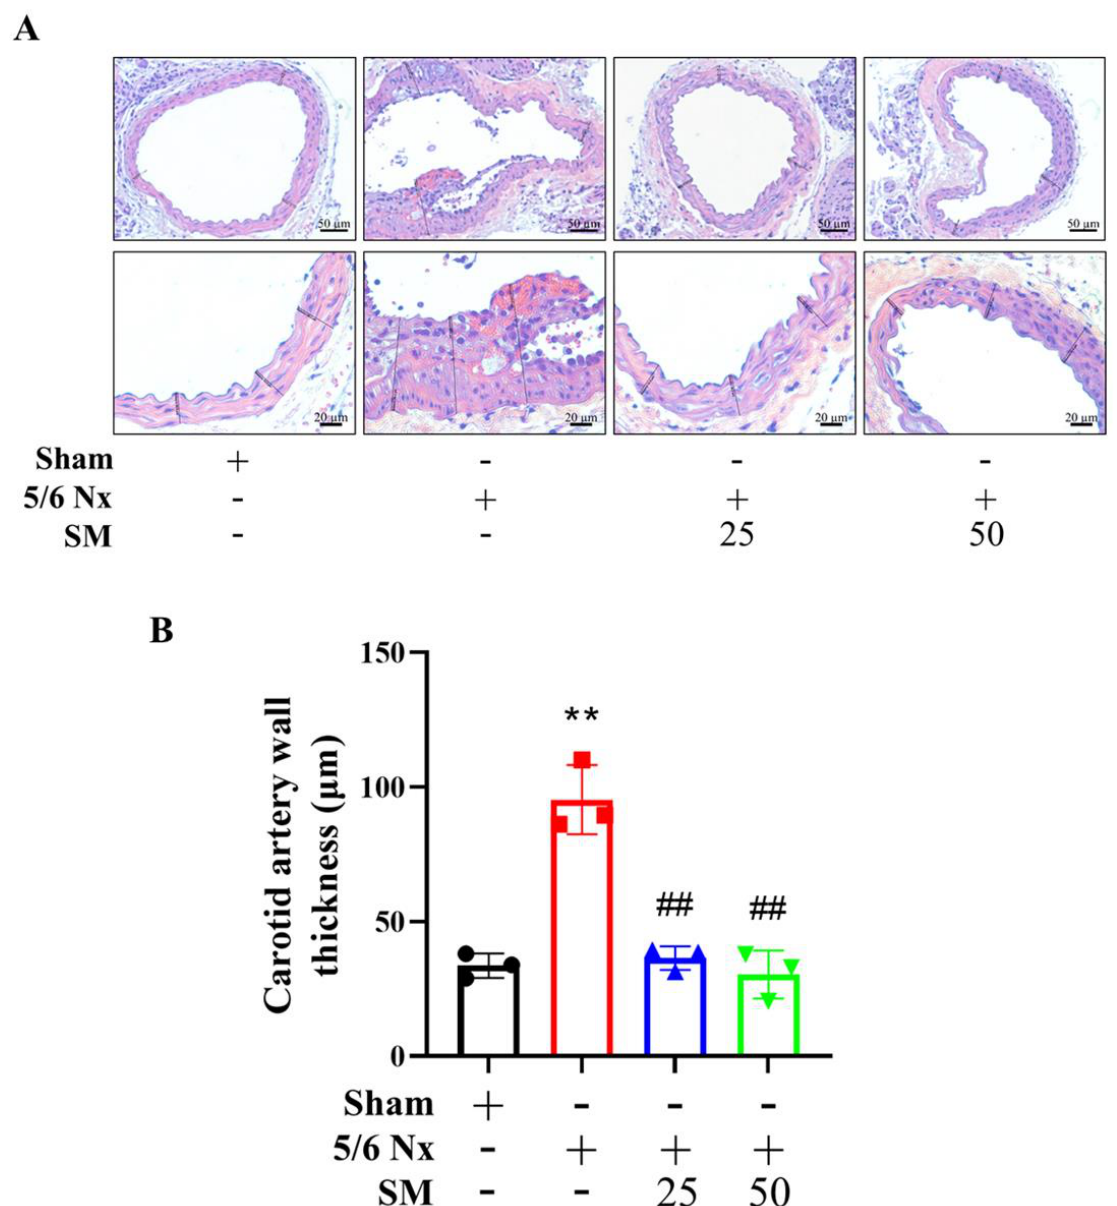
Figure 2. Hematoxylin and eosin staining shows the histopathology of atherosclerotic plaques. ( A ) Representative photomicrograph of ApoE –/– mouse carotid artery (top panel, 200 × and bottom panel, 400 × ). During the entire experiment, no obvious atherosclerotic lesions were found in the carotid artery of the sham group, and severe atherosclerosis was found in the carotid artery of the 5/6 Nx group. As the concentration of SM increased, the development of atherosclerotic lesions gradually decreased. ( B ) Wall thicknesses were quantified by unwitting researchers. Data are presented as mean ± SEM ( n = 3 per group). ** p < 0.01 vs. sham group; ## p < 0.01 vs. 5/6 Nx group in ApoE –/– mice.